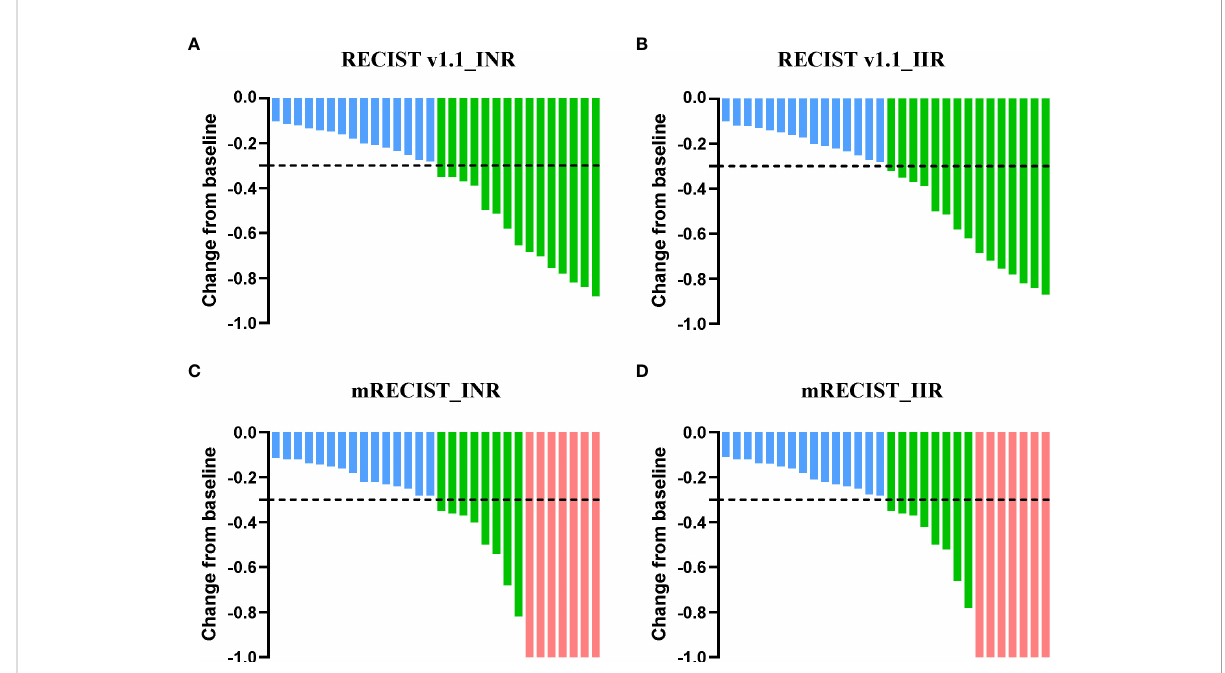
FIGURE 2 Percent change of the sum of tumor diameters from baseline. Percent change of total tumor diameters from baseline by INR (A) and IIR assessment (B) according to RECIST Version 1.1. Overall percent change from baseline in tumor size by INR (C) and IIR assessment (D) according to mRECIST criteria. Each bar represents one patient. INR, Investigator review; IIR, Independent imaging review; mRECIST, modi fi ed response evaluation criteria in solid tumors.